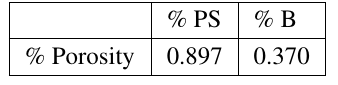
Table 6. Correlation table for porosity of Bagasse based